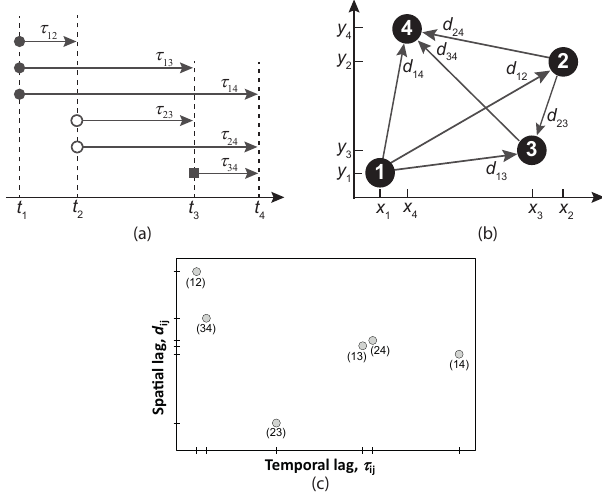
Figure 1. Illustration of our clustering analysis methodology. (a) A sequence of four point events occur at times t 1 , t 2 , t 3 , t 4 . The six temporal lags τ 12 , τ 13 , τ 14 , τ 23 , τ 24 , τ 34 are shown. (b) The two- dimensional locations of the four point events are shown. The six spatial lags, d 12 , d 13 , d 14 , d 23 , d 24 , d 34 are also shown. (c) The six spatial lags d ij are shown as a function of the corresponding temporal lags τ ij , where i is the first event and j is the second event in